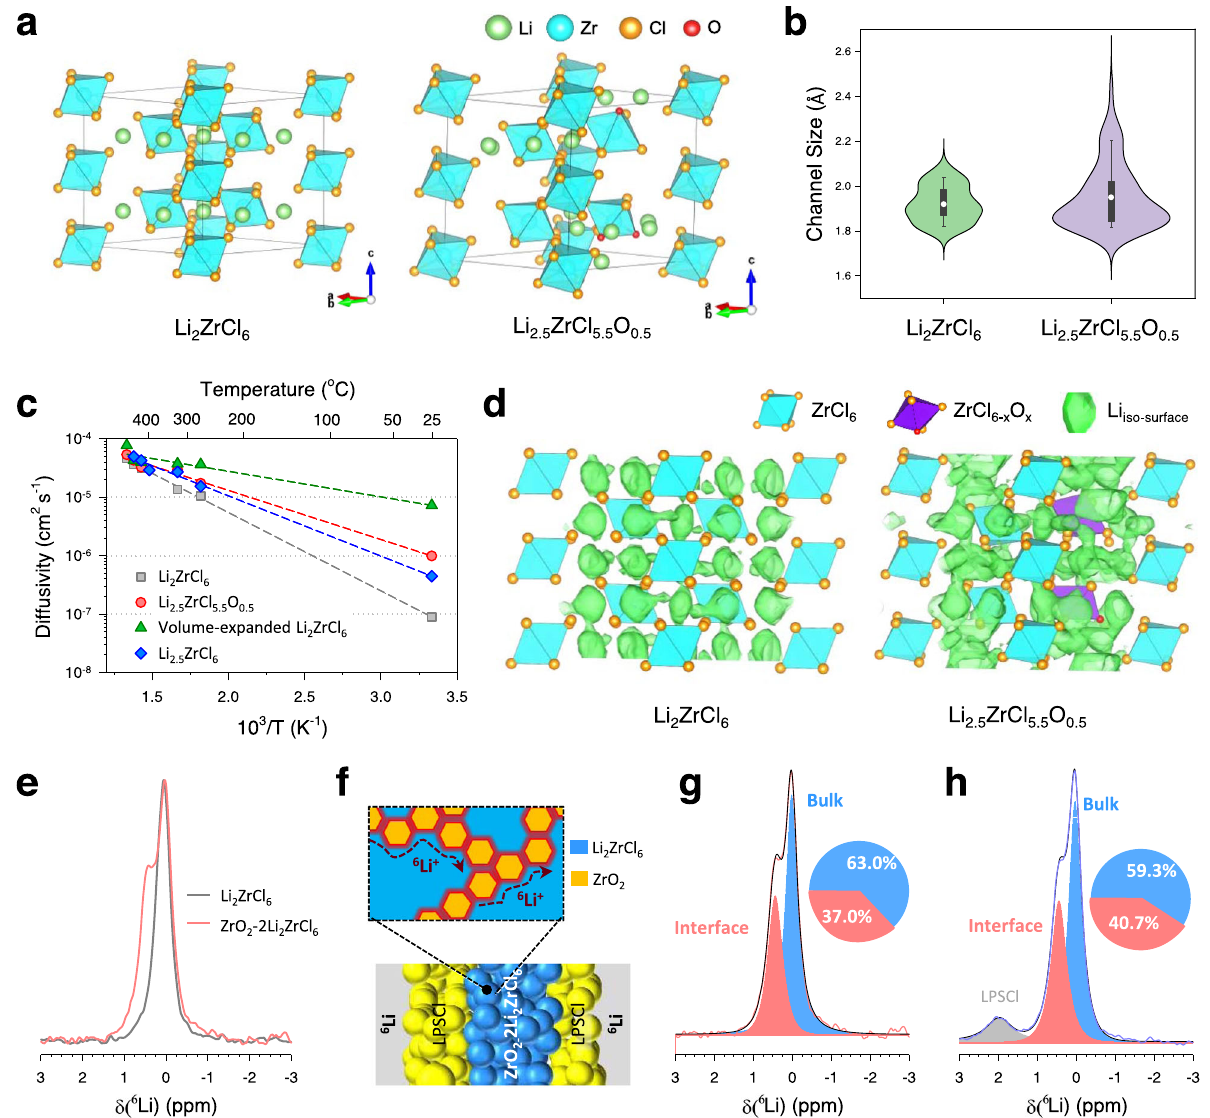
Fig. 3 | Interfacial Li + superionic conduction in HNSEs. a Crystal structures of Li 2 ZrCl 6 andLi 2.5 ZrCl 5.5 O 0.5 . b TopologicalanalysisandchannelsizeofLi 2 ZrCl 6 and Li 2.5 ZrCl 5.5 O 0.5 . The white circle, box and whisker indicate the mean value, values fromthe25%tothe75%percentilesandvaluesfromthe10%tothe90%percentiles, respectively. c Arrhenius plots of the AIMD simulation extrapolated to 300K. d Li